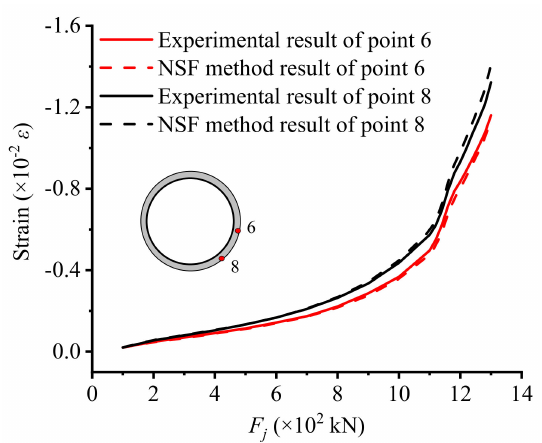
Figure 5. The comparison between experimental and interpolated strain of CFST arch